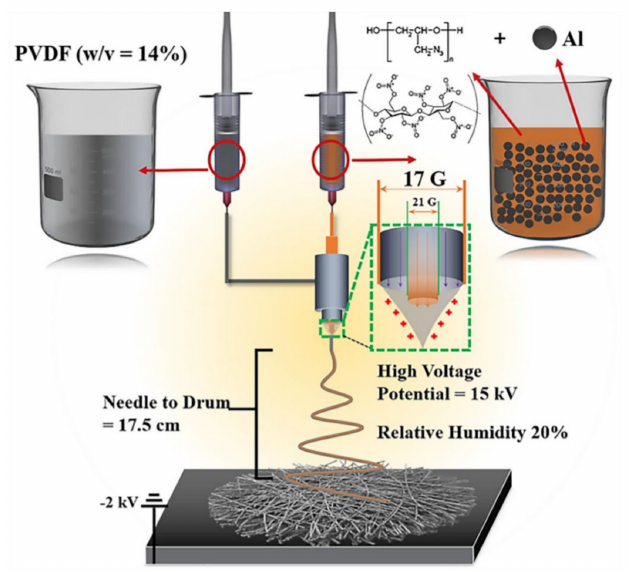
Figure 2. Schematic diagram of the preparation of the Al@GAP/NC/PVDF composite film by the coaxial spinning method [10].